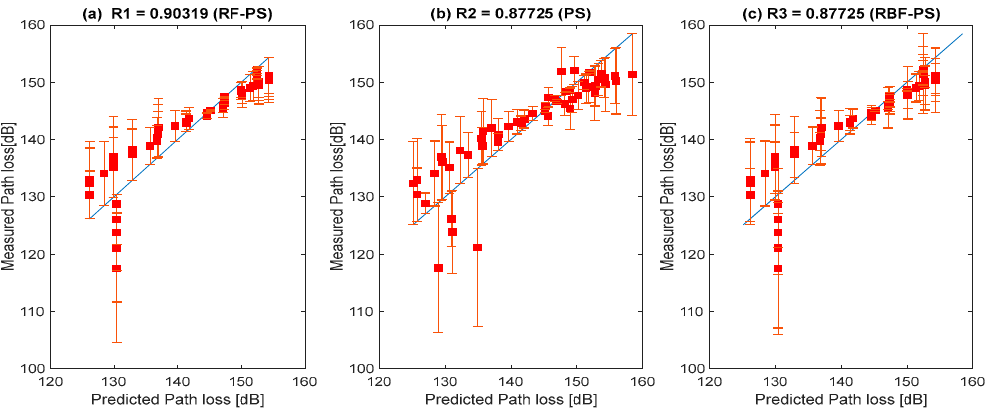
Figure 29. Results showing the correlation between the measured path loss and predicted path loss using the hybrid RF-PS prediction method and two existing standard path loss prediction methods in site 1 of location 4.